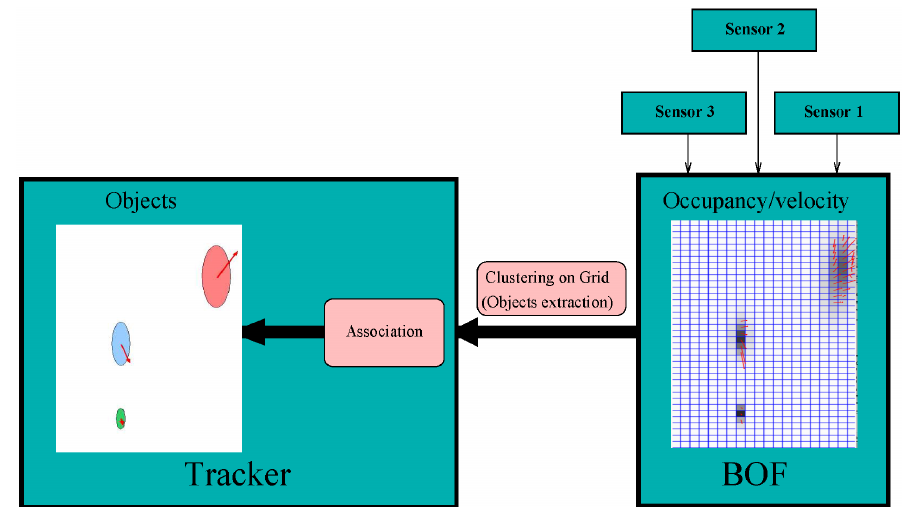
Figure 8. Fast Clustering-Tracking algorithm scheme extracted from Meckhnacha et al. [32]. Reproduced with permission from reference [32]. Copyright 2008